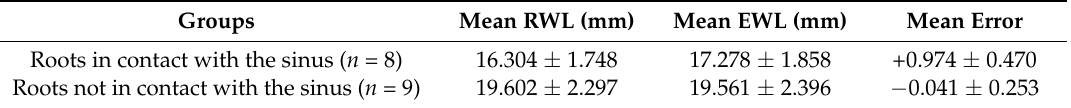
Figure 4. EWL versus RWL of palatal roots not in contact with the sinus. Table 1. Mean and standard deviation measurements (in mm) of differences between the EWL and the RWL.